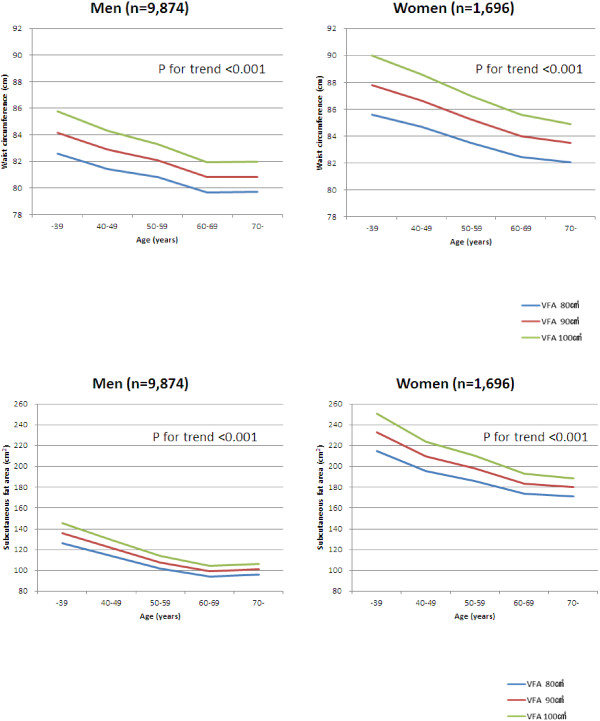
WC or SFA values, corresponding to VFA values, stratified by age group. P for trend across the age groups was calculated as the statistical significance of the partial regression coefficient of an age group (coded as consecutive integers) in a multiple linear regression analysis, where the dependent variable was WC (or SFA) and the independent variables were VFA and age group.